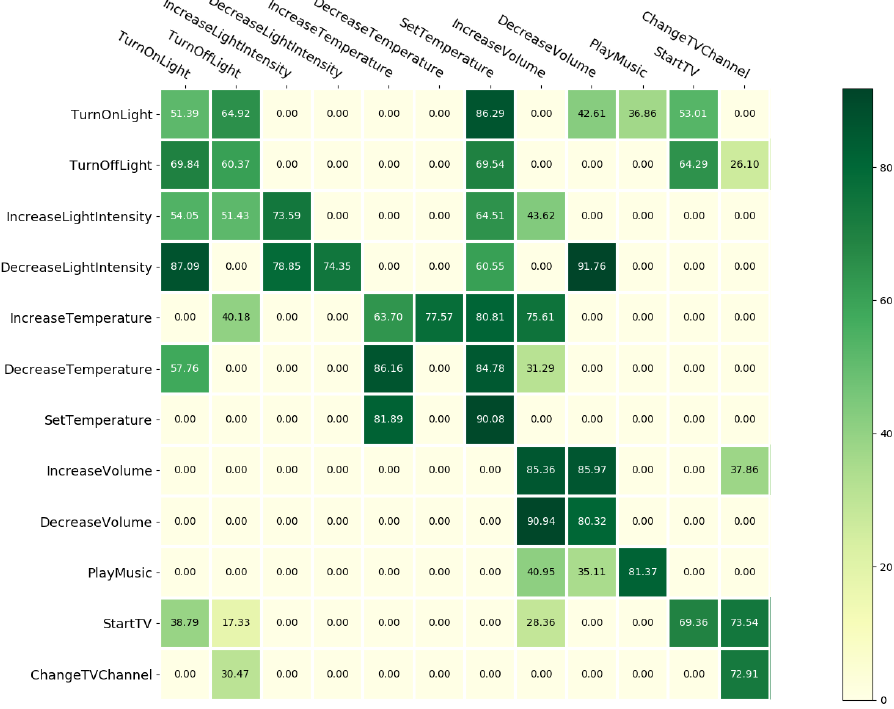
Figure A2. Confidence matrix for Scenario